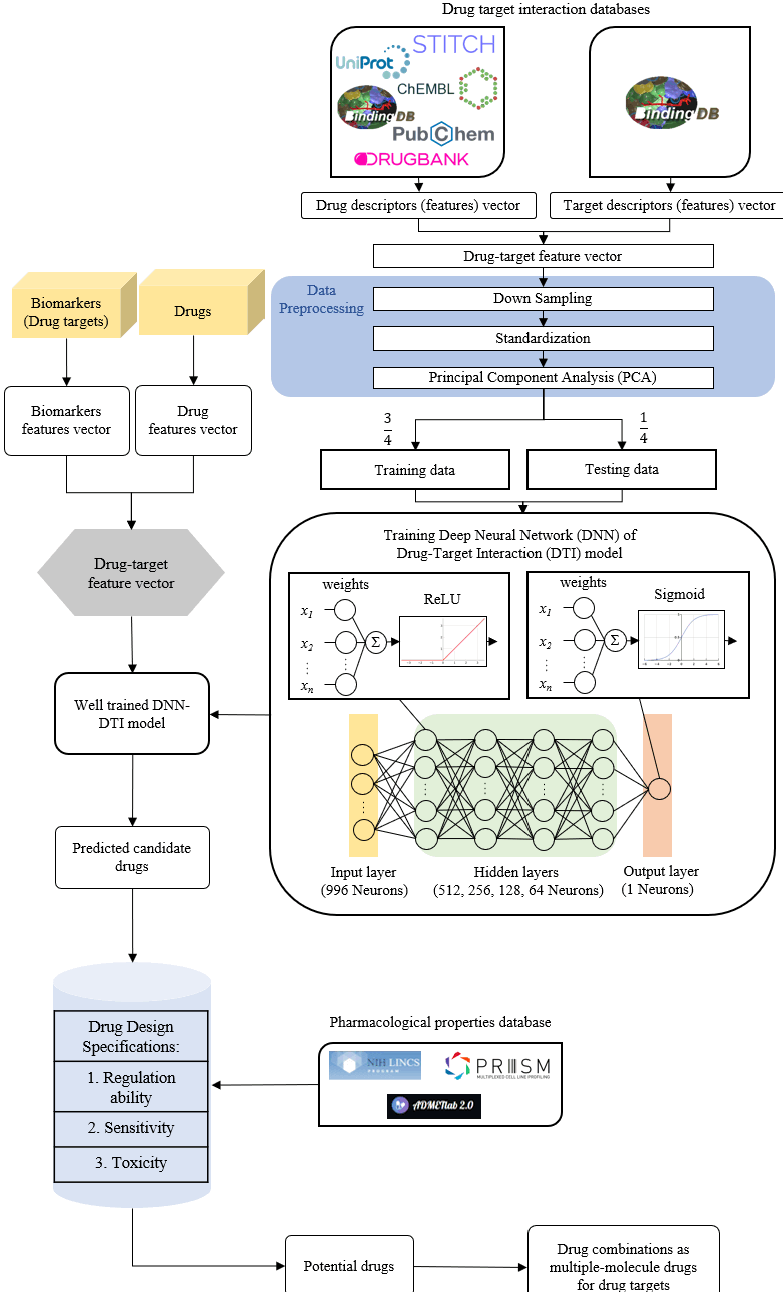
Figure 3. The flowchart of systematic drug design and discovery of MIBC and ABC. The drug-target interaction databases contain drug-target interaction data to construct the drug-target feature vector. After data preprocessing, the data is divided into training data and testing data to train the DNN-based DTI model. The feature vectors of biomarkers and drugs from drug-target interaction databases are used for the well-trained DNN-based DTI model to predict candidate drugs for the identified biomarkers (drug targets) of MIBC and ABC. The candidate drugs are then filtered by the drug design specifications to obtain potential drug combinations as multiple-molecule drugs for the treatment of MIBC and ABC.